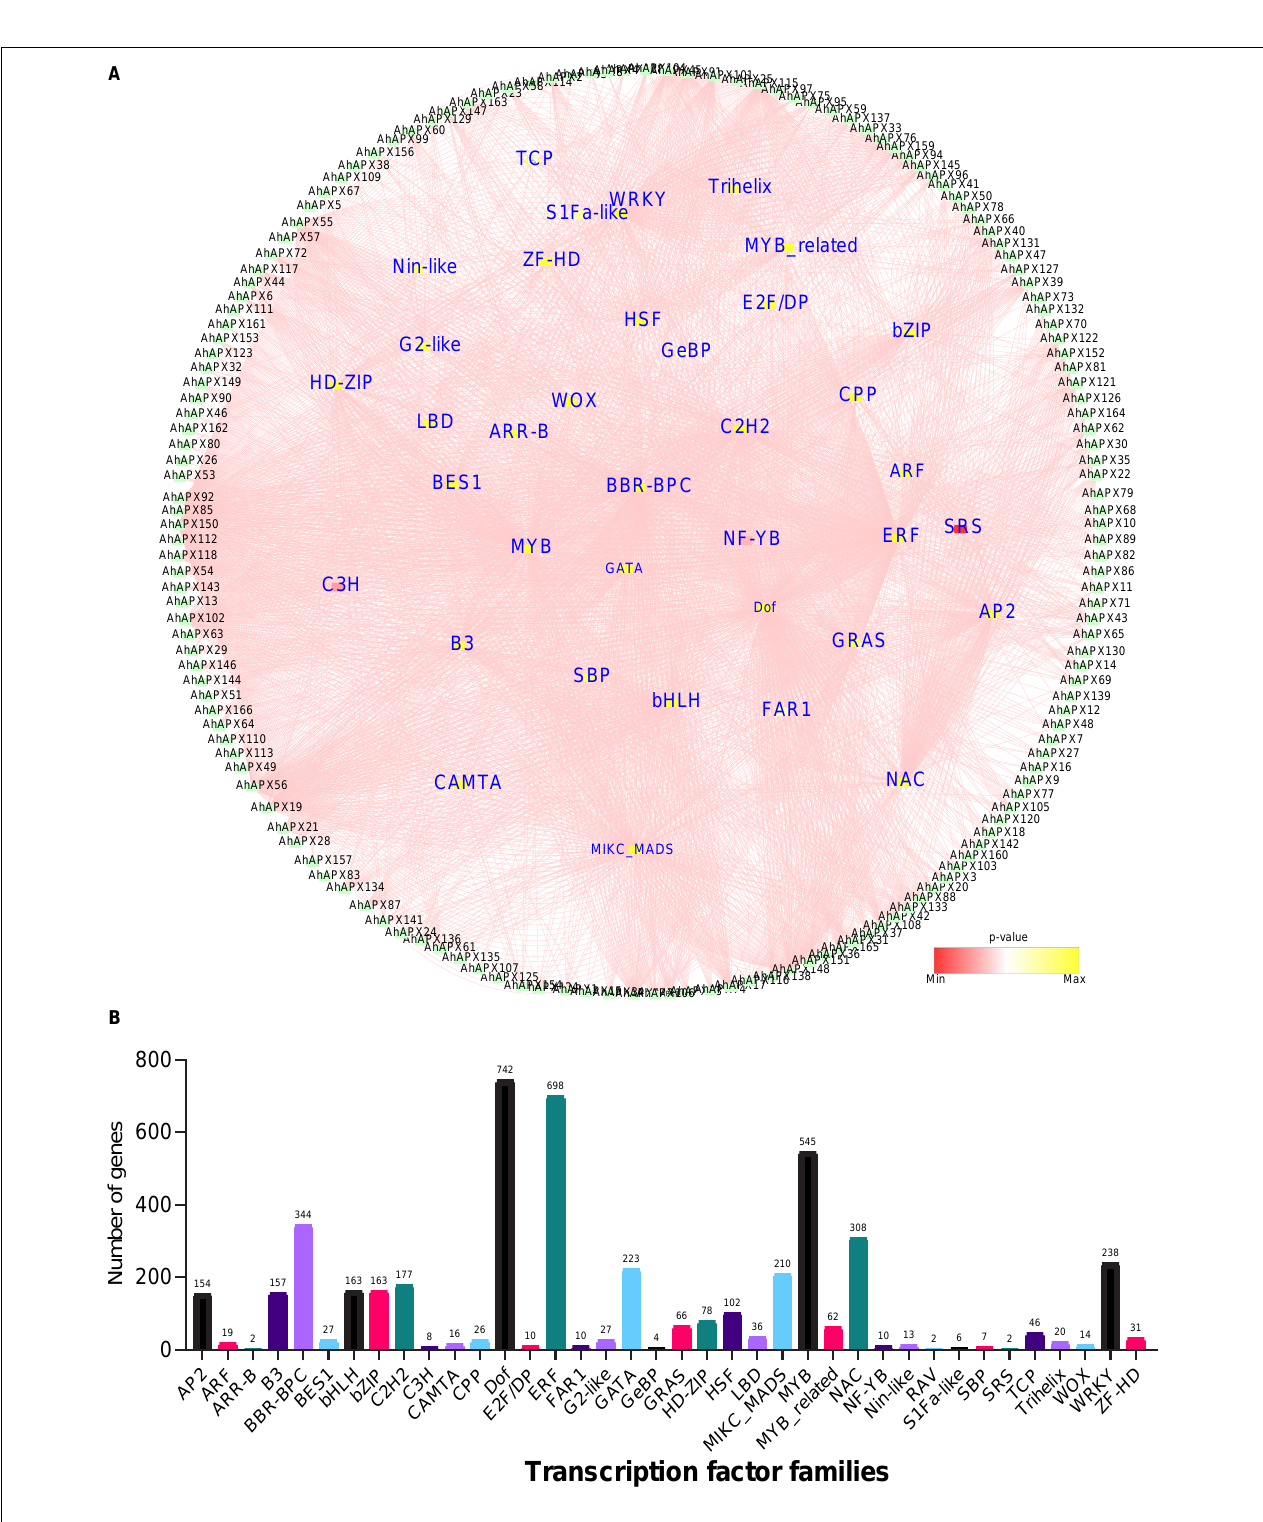
FIGURE 9 | The regulatory network of putative transcription factors of AhAPX genes. (A) Circular network of transcription factors. AhAPX genes are shown around the circle. The small inner circles denote the transcription factors, and their color pink to yellow represents the degree of interaction. (B) Graph indicates the number of AhAPX genes and their representative putative transcription factor families. The complete dataset of putative transcription factors is shown in Supplementary Table 7 .